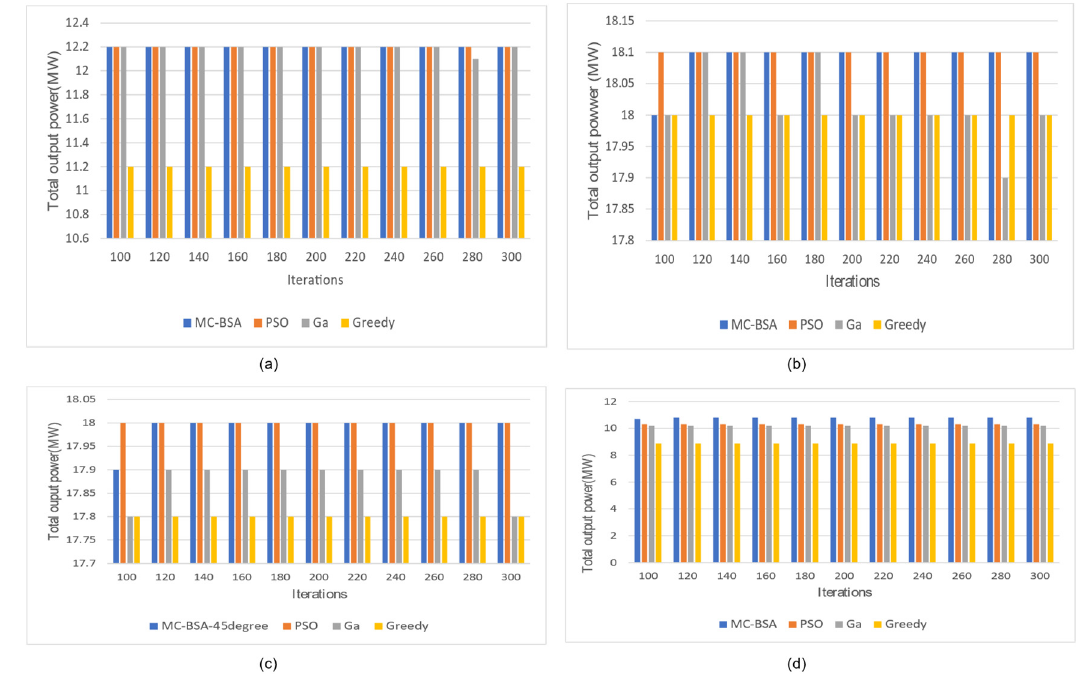
Figure 10. The total power output of 3 × 3 matrix OWF on MC-BAS algorithm compared to the iteration algorithms: ( a ) ϕ = 0 ◦ ; ( b ) ϕ = 25 ◦ ; ( c ) ϕ = 45 ◦ ; ( d ) ϕ = 90 ◦ .